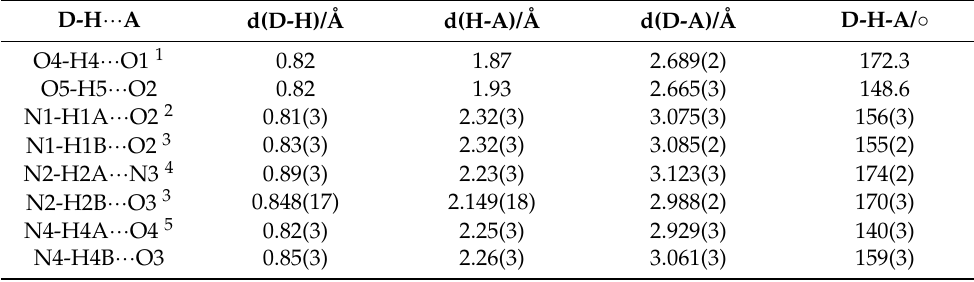
Table 2. Hydrogen bonded geometries for